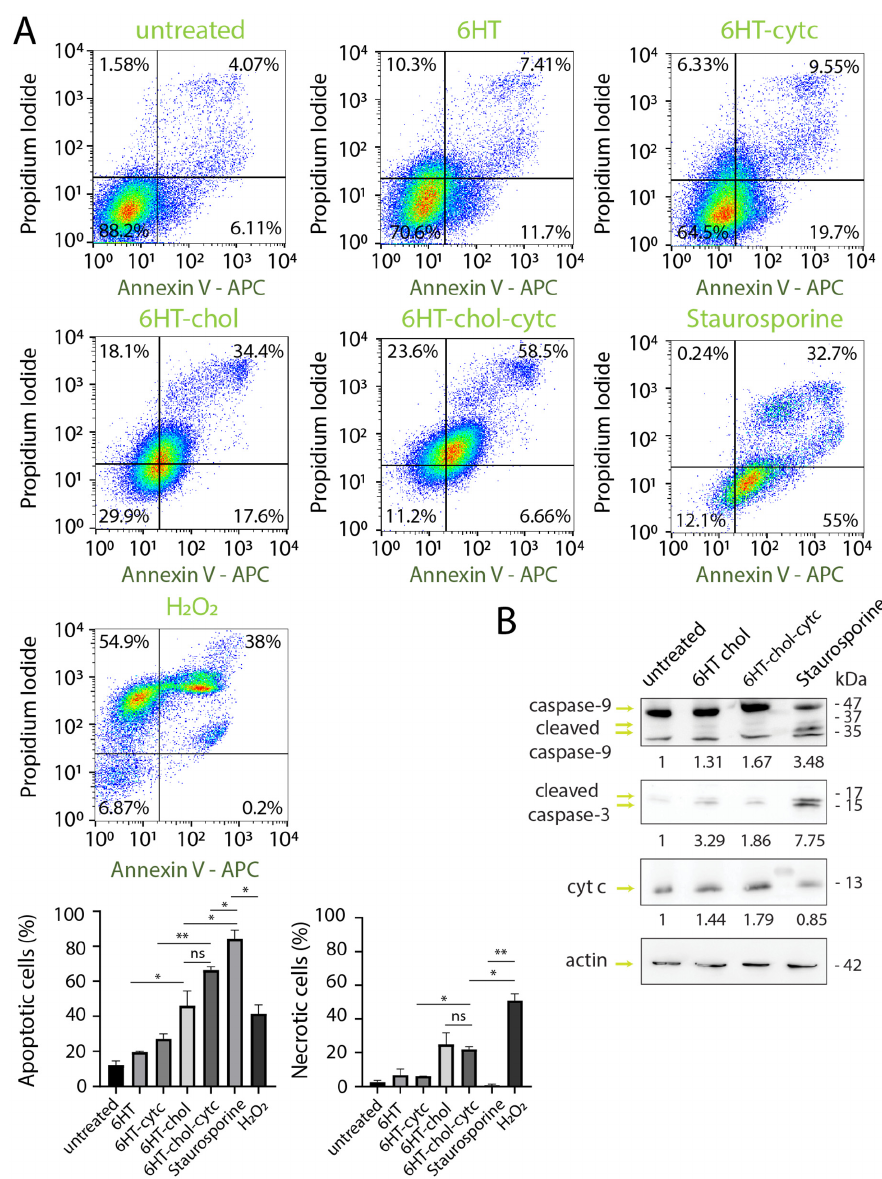
Figure 5. Cholesterol-conjugated DNA nanotubes triggered cell death in HeLa cells. ( A ) Flow cytometry of Annexin V/Propidium Iodide-stained cells after 4 h of treatment with DNA nanotubes showing an increase in apoptotic and necrotic fractions of cell populations treated with the cholesterol-modified DNA nanotubes. The percentage of apoptotic cells for each condition is plotted in the bar graph showing the sum of cells in the right quadrant: Q2 (early apoptotic cells, below) and Q3 (late apoptotic cells, above). The percentage of necrotic cells for each condition is plotted in the bar graph showing the cells in the top left quadrant: Q4 (necrotic cells). n = 3. Statistical analysis was performed by an unpaired t -test. ns = no statistical difference, * p < 0.05, ** p < 0.01. ( B ) Western blot analysis to monitor caspase 3, 9 and cytochrome c in HeLa cells 24 h after incubation with DNA nanotubes. Actin was used as loading control, and staurosporine was used as a positive control of apoptosis. Band intensity was determined by normalizing first to actin and then to the untreated control